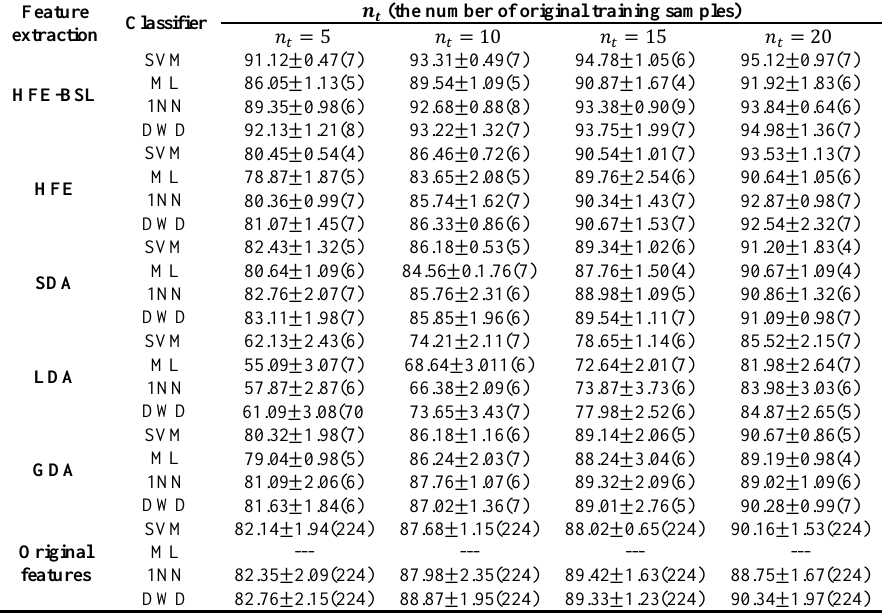
Table 6. Highest average classification accuracies and their corresponding standard deviations achieved using SVM, ML, 1NN and DWD classifiers with features extracted by HFE-BSL, HFE, SDA, LDA, GDA, and using original features for synthetic dataset. Number in parenthesis represents number of features achieving highest accuracies in